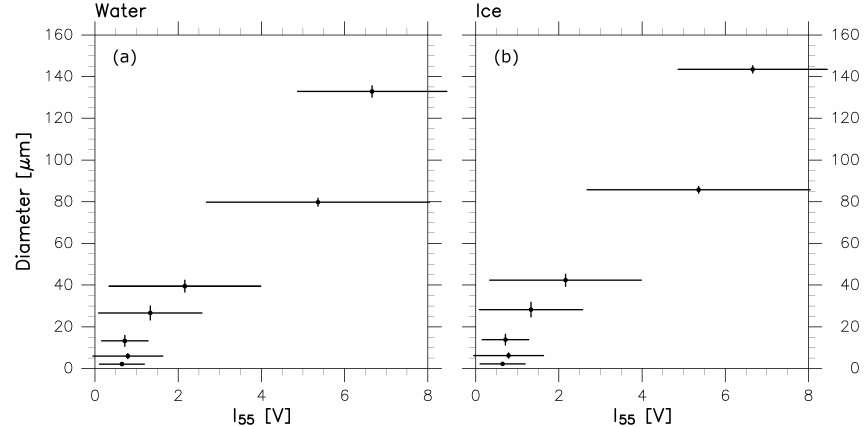
Figure A1. Relationship between I 55 and the diameters of spherical water droplets (left) and hypothetical spherical ice particles (right) based on Table A2 and the summary column of Table A3. The horizontal bars indicate the standard deviation range obtained from the laboratory experiments, while the vertical bars indicate the minimum and maximum diameters obtained from the Mie scattering calculations.